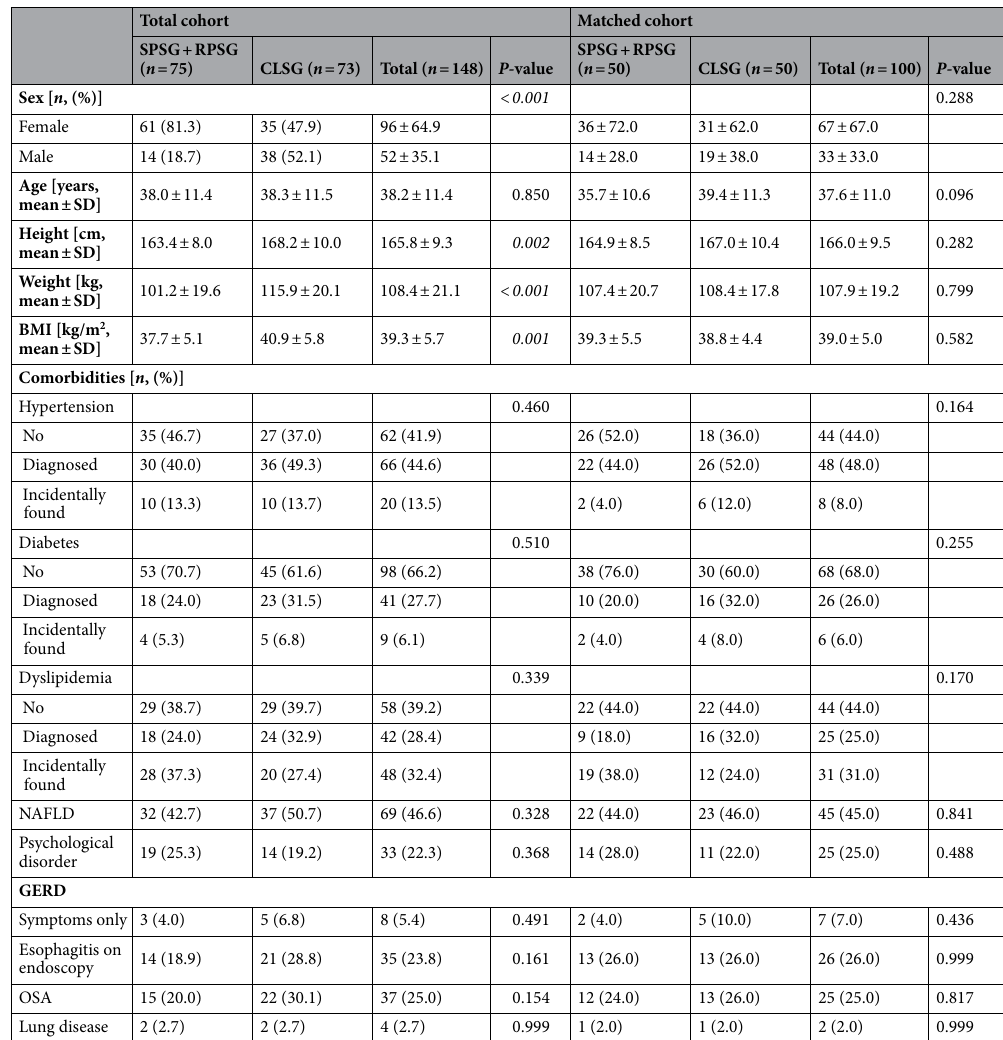
Table 1. Clinical characteristics of the total and propensity score-matched cohorts. Significant values are italics. SPSG single-port sleeve gastrectomy, RPSG reduced port sleeve gastrectomy, CLSG